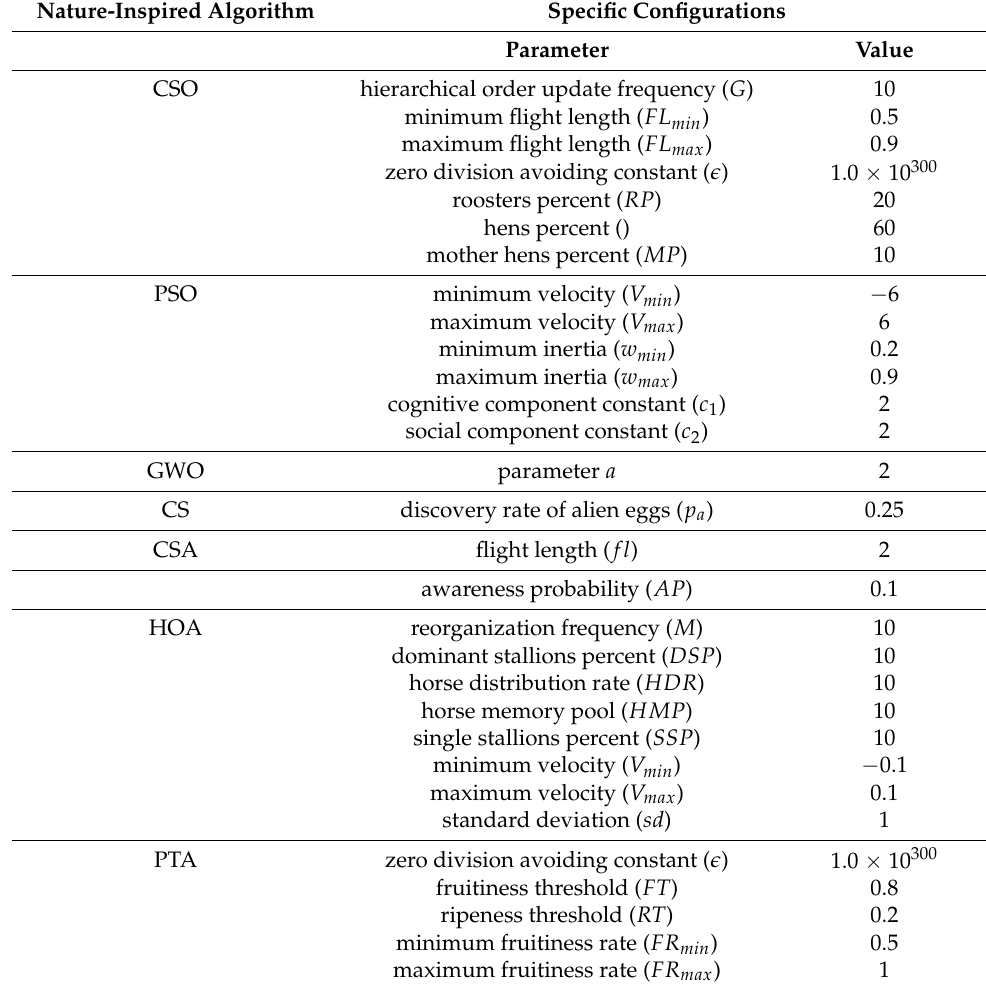
Table 5. Nature-Inspired Algorithms’ Specific